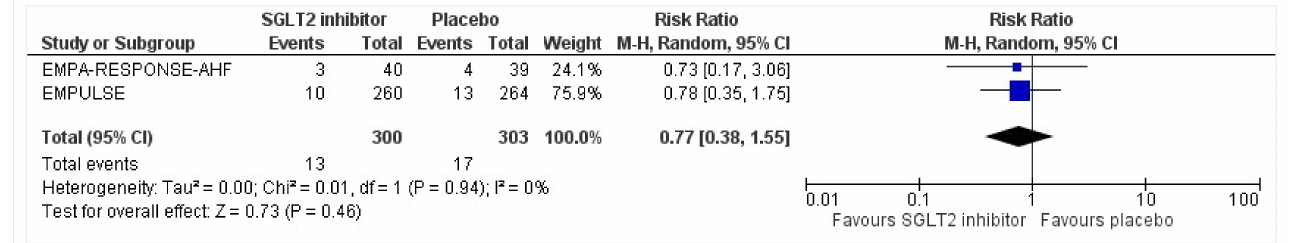
Figure 8. Forest plot for the total number of patients who had acute renal failure as a serious adverse event during the duration of treatment in either group [25–27].